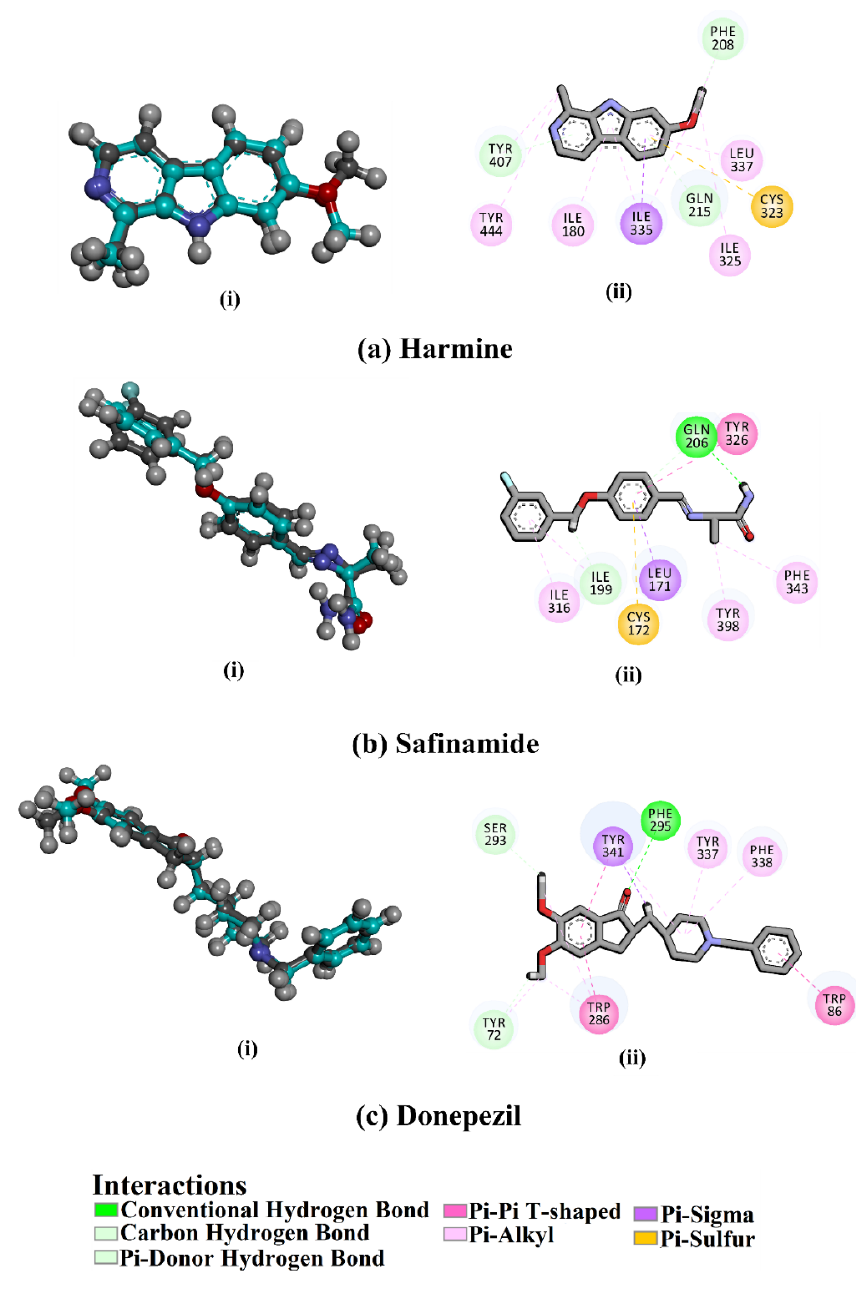
Figure 4. ( i ) 3D molecular interaction of the native structure (in cyan) and the anticipated docking pose (in gray) and ( ii ) 2D molecular interaction of the anticipated docking pose of ( a ) harmine with MAO-A, ( b ) safinamide with MAO-B, and ( c ) donepezil with AChE.